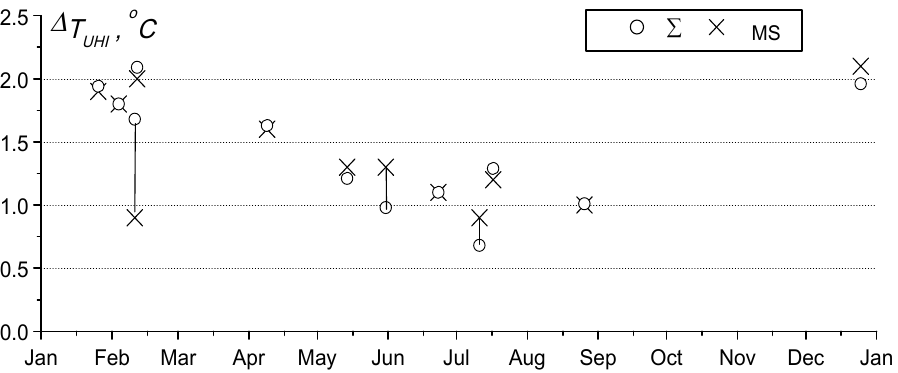
Figure 6. Comparison of the calculated temperature change in the city under the effect of all fluxes (∑) with that measured by the mobile station (MS).